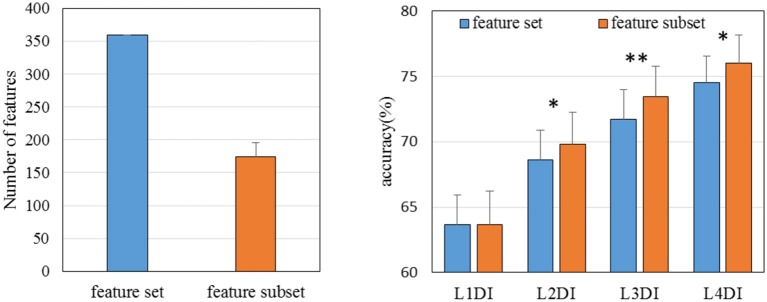
The performances of SVMs trained and tested with all 360 features and the feature subset (mean feature numbers was 174 across 17 subjects), respectively. *P < 0.05; **P < 0.01.